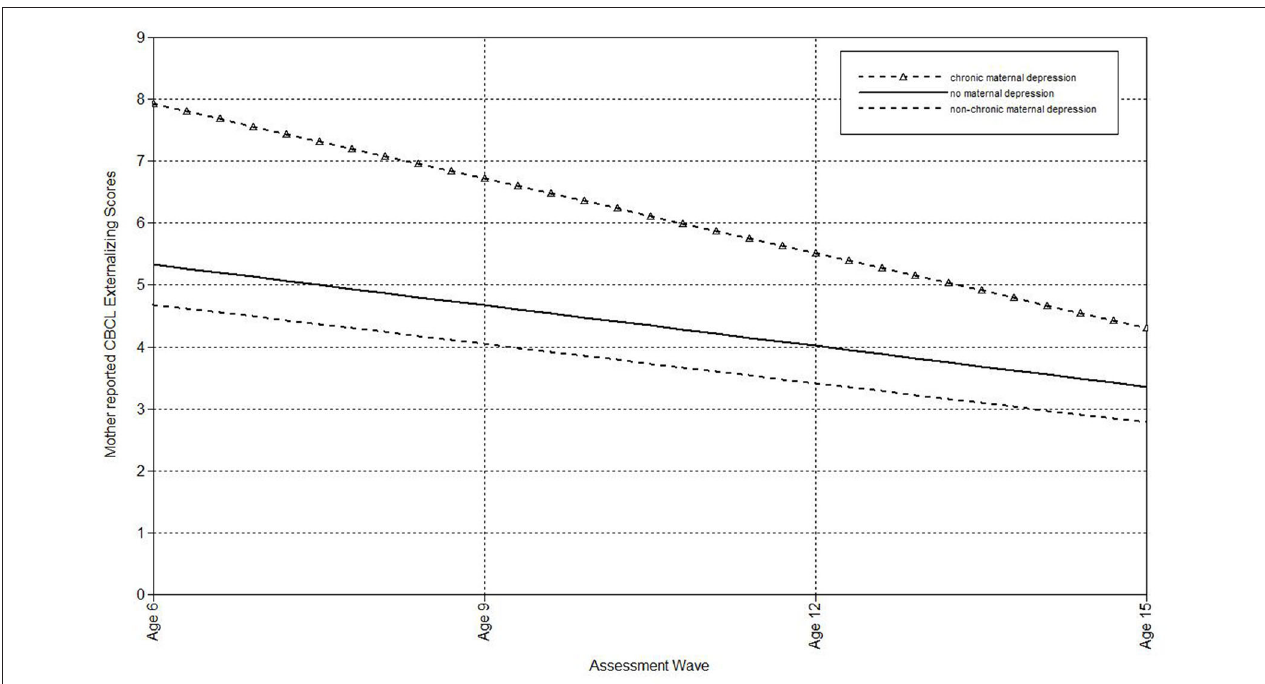
FIGURE 2 | Effect of chronic maternal depression (DSM approach) on the slope of mother-reported CBCL Externalizing scores in